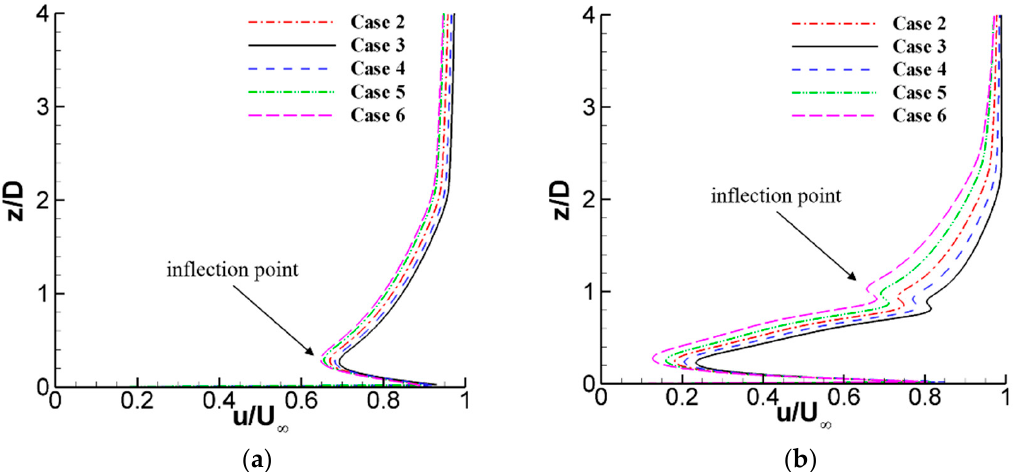
Figure 10. Comparison of x -velocity profiles at ( a ) 𝑥 𝐷 = −2.0⁄ and ( b ) 𝑥 𝐷 = 2.0⁄ on mid-span plane of Case 2–6. of Case